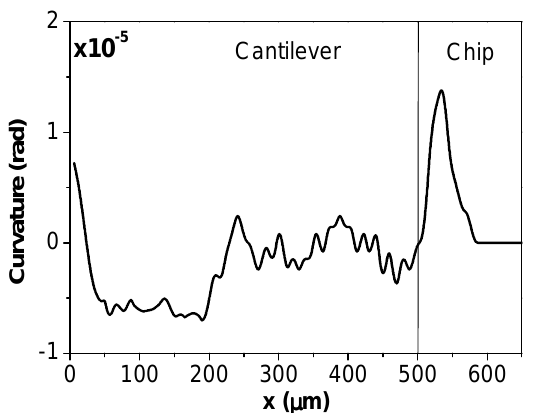
Figure 4. Curvature of the cantilever recorded by the scanning laser set-up. The local change of curvature indicates the position and extension of the adsorbed droplet on the